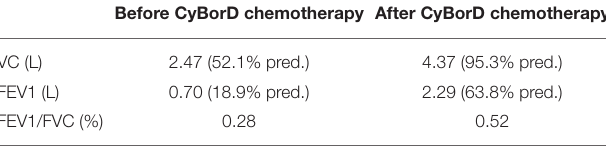
TABLE 1 | Pulmonary ventilation function test before and after CyBorD chemotherapy. Before CyBorD chemotherapy After CyBorD